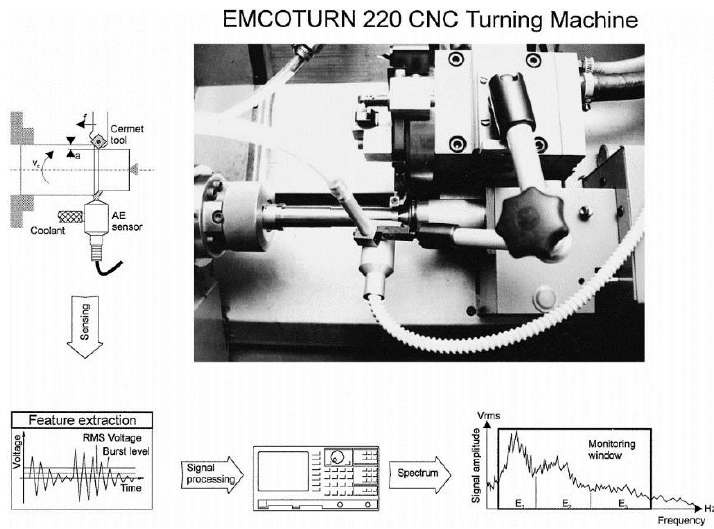
Figure 5. An example of acoustic emission based indirect tool condition monitoring system